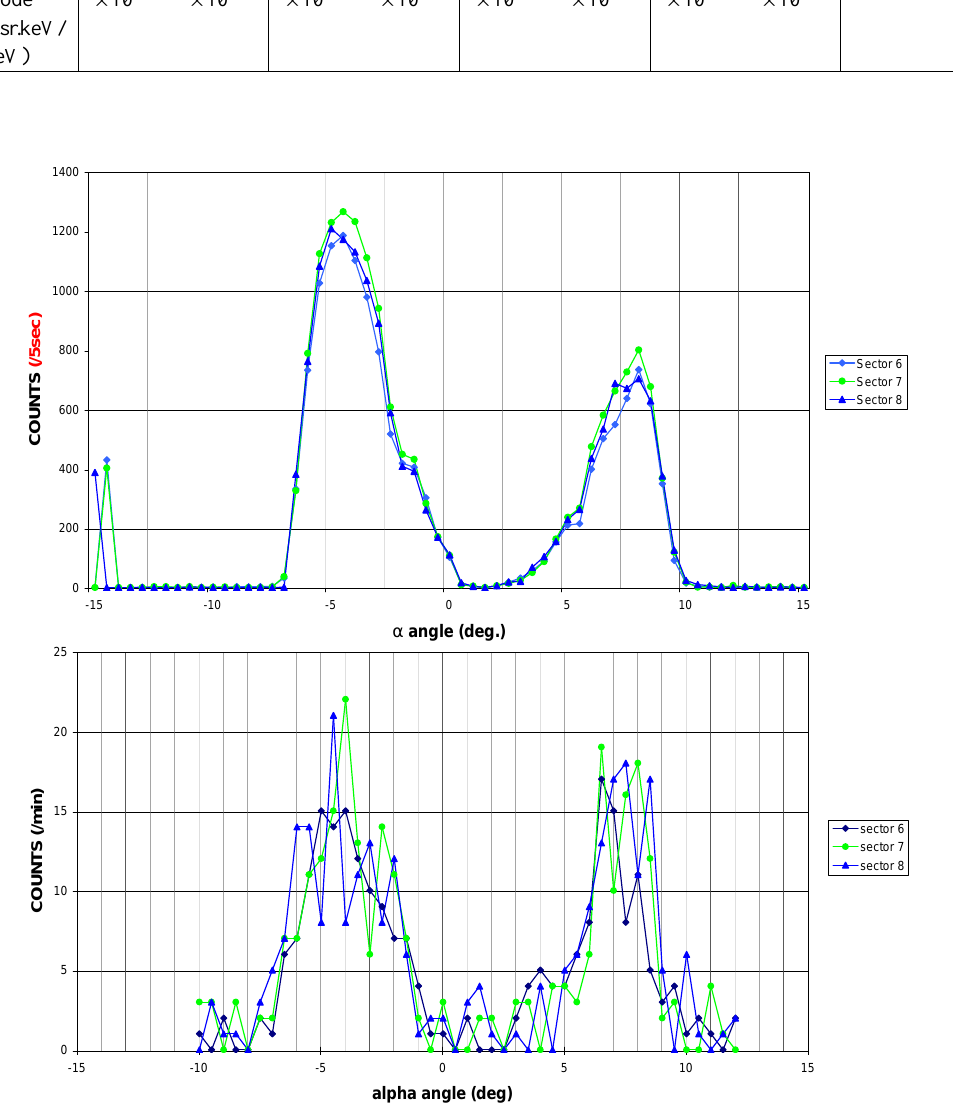
Fig. 7. UV effects on a Cluster-1 HIA model (counts/5s) in Fig. 7 (a) and on a Cluster-2 HIA model (counts/min) in Fig. 7 ( b) in the function of the polar angle. The background for Cluster-2 has been divided by two orders of magnitude by improving the analyser